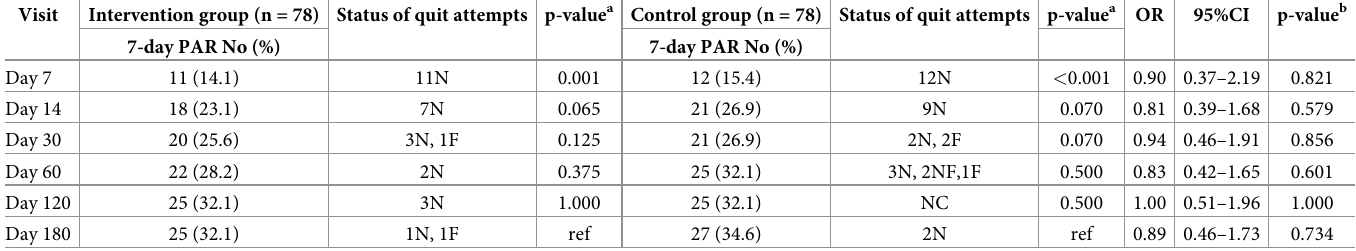
Table 3. Comparisons of 7 day-point abstinence (PAR) rates between visits between the intervention and control groups on days 7, 14, 30, 60, 120, and 180.